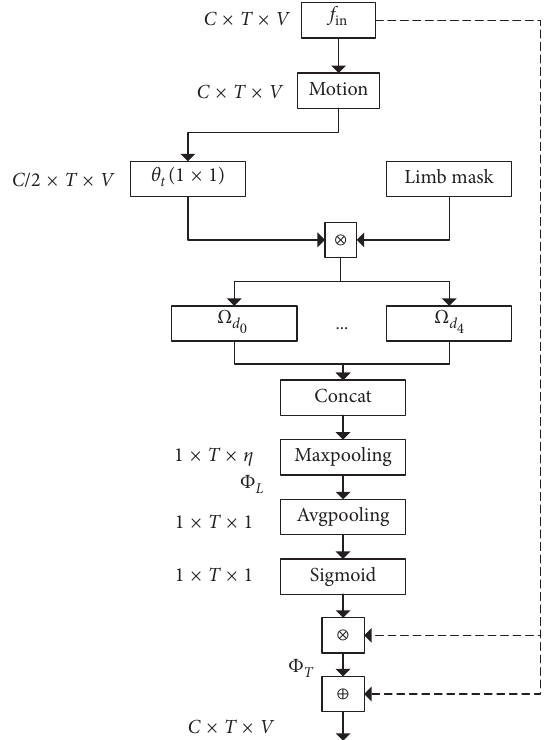
Figure 1: Local posture motion-based temporal attention (LMP- TAM)